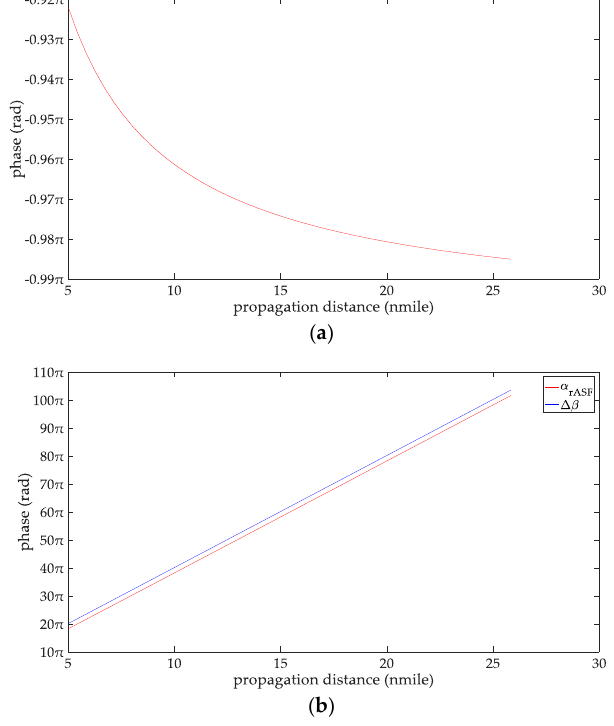
Figure 2. ( a ) The phases of the reflection coefficient changing with the propagation distance; and ( b ) the ASFs of the AIS reflected signal changing with the propagation distance.